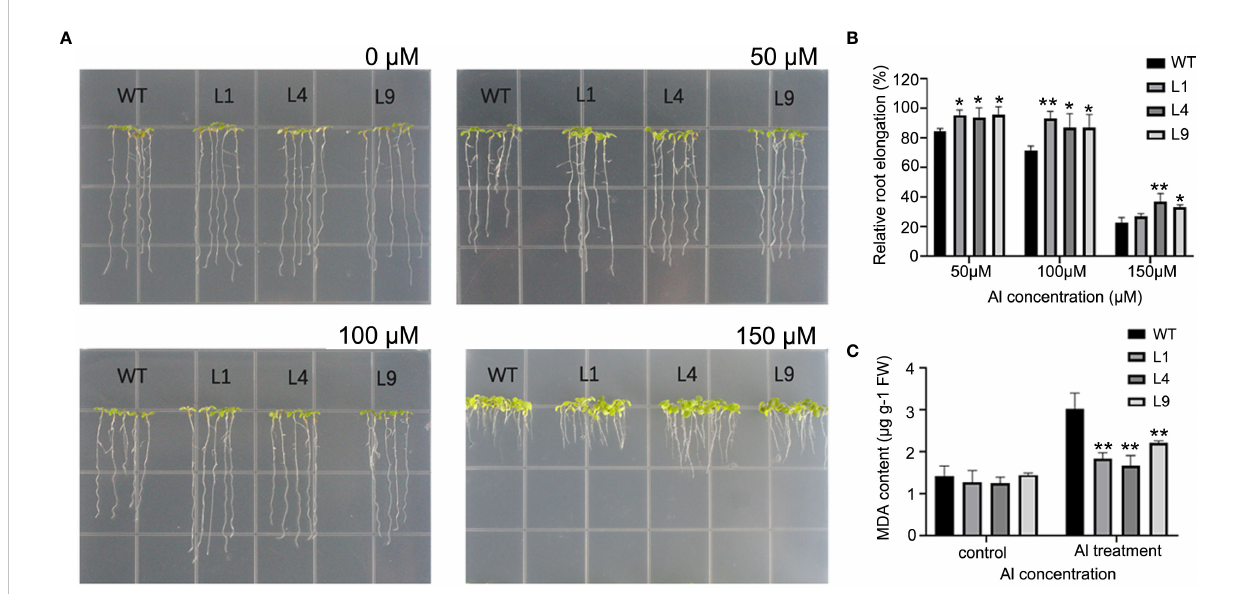
FIGURE 4 Overexpression of GmABR1 enhances Al resistance in transgenic Arabidopsis. (A) Root growth of WT and GmABR1 transgenic Arabidopsis under 0 µM, 50 µM, 100 µM, 150 µM AlCl 3 (pH4.5). (B) Relative root elongation of WT and GmABR1 transgenic Arabidopsis. (C) MDA content in leaves of WT and GmABR1 transgenic Arabidopsis. The asterisk indicated that there was signi fi cant difference between WT and GmABR1 transgenic lines ( *P < 0.05; **P < 0.01). WT: Columbia-0; L1, L4, L9: GmABR1 transgenic lines of T 3